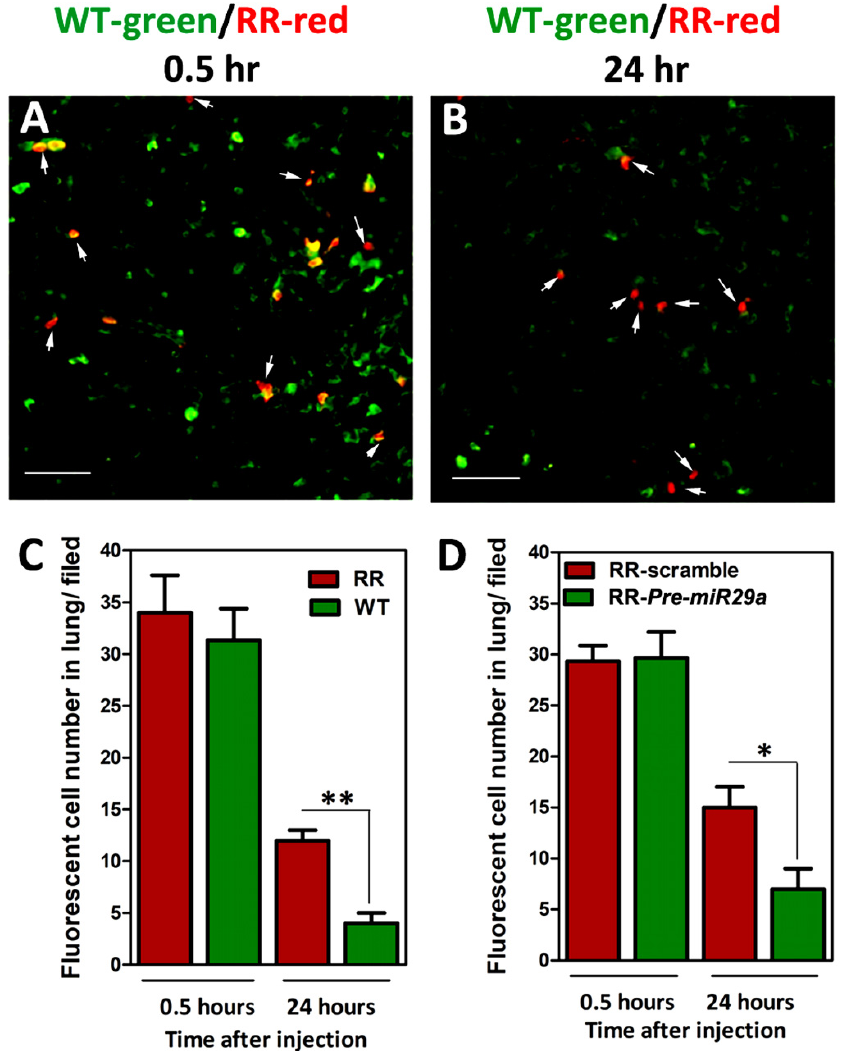
Figure 5. Augmented lung localization and survival rate after tail-vein injection of radioresistant (RR)-CaSki cells in BALB/c nude mice, and exogenous administration of miR-29a remarkedly abridged the radioresistance-enhanced lung localization. Wild-type (WT)-CaSki cells (green fluorescence) and RR-CaSki cells (red fluorescence) were mixed in a 1:1 ratio and injected into BALB/c nude mice through tail-vein injection. A representative fluorescence micrograph is shown of frozen sections of mouse lung at ( A ) 0.5 h and ( B ) 24 h post-tail-vein injection. White arrows indicate the red fluorescent RR-CaSki cells. Scale bar = 200 μ m. The results were collected from six mice in each group, and the results were similar. ( C ) Summary of number of fluorescent cells in lung (red fluorescence indicating RR-CaSki cells vs. green fluorescence indicating WT-CaSki cells). ( D ) Summary of number of fluorescent cells in lung (red fluorescence indicating RR-CaSki cells transfected with Scrambled NC (100 nM) vs. green fluorescence indicating RR-CaSki cells transfected with Pre miR-29a; 100 nM). Data are the mean ± SD from six independent experiments. * p < 0.05, ** p < 0.05.